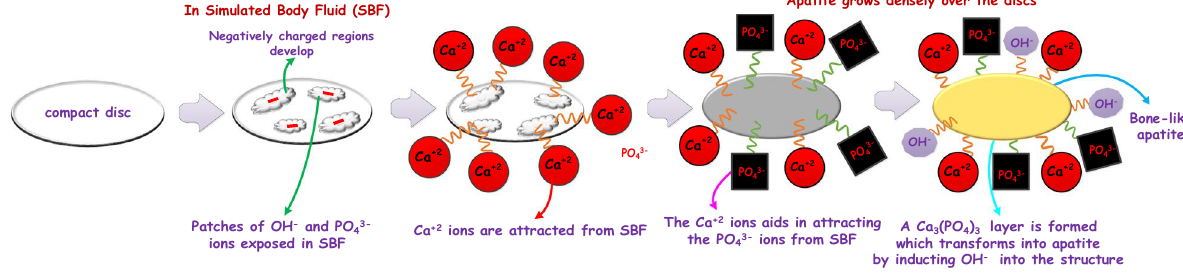
Figure 5. A schematic diagram of the probable mechanism of apatite nucleation in SBF over the surfaces of the discs. The nucleation mechanism is mainly related to the electrostatic forces that draw different ions from the SBF onto their surface. The illustration has been created using Visio 16 available at https:// suppo rt. micro soft. com/ en- us/